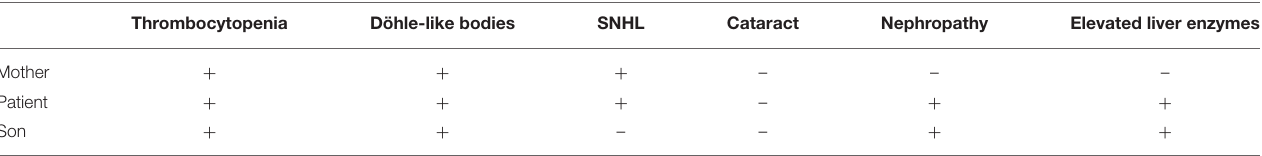
TABLE 1 | Clinical manifestations of the family. Thrombocytopenia Döhle-like bodies SNHL Cataract Nephropathy Elevated liver